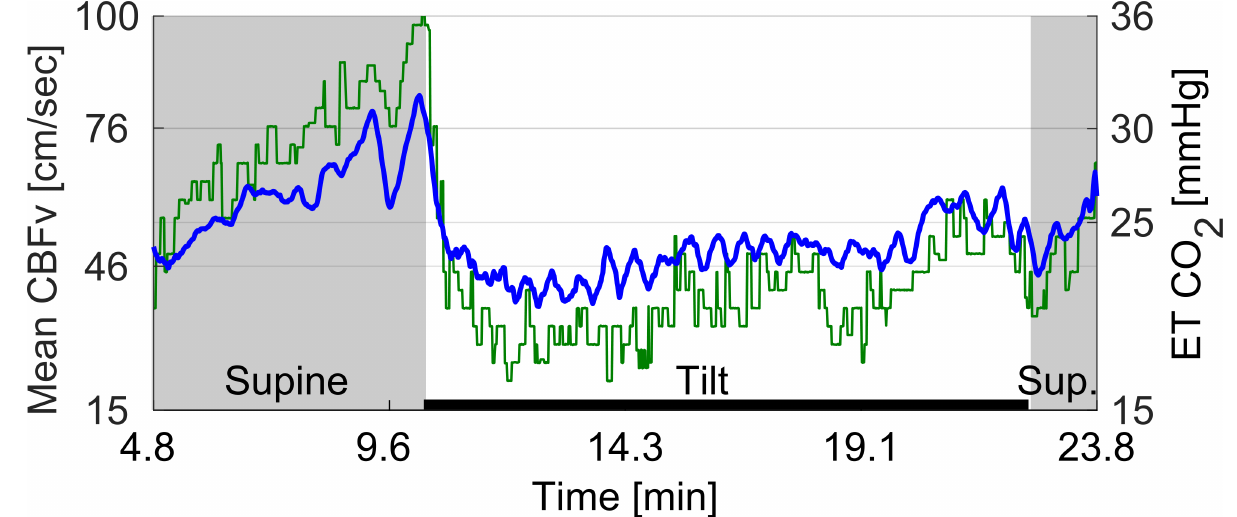
Fig 4. Superimposed end tidal CO 2 and mean cerebral blood flow velocity from the same patient as in Fig 3.